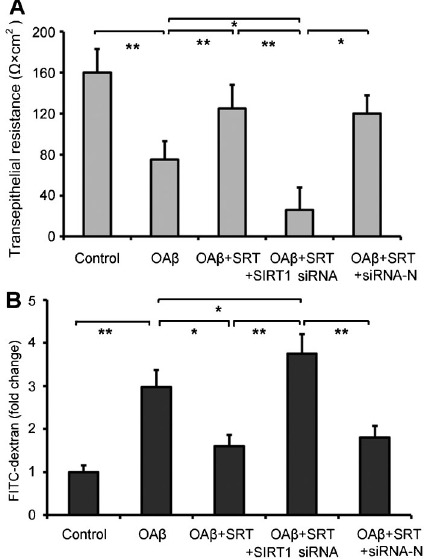
Figure 5. Effects of A b , SRT1720 and knockdown of SIRT1 on the barrier integrity of RPE monolayers. A , Measurement of trans- epithelial resistance (TER) of retinal pigment epithelial (RPE) cells. B , Analysis of transepithelial permeability by measuring the passive permeation of FITC-dextran. Normal or siRNA-transfected RPE cells were cultured for 15 days after TER stabilization, and then left untreated (control) or exposed to 0.3 m M OA b for 24 h with or without 5 m M SRT1720 pretreatment for 1 h. OA b induced